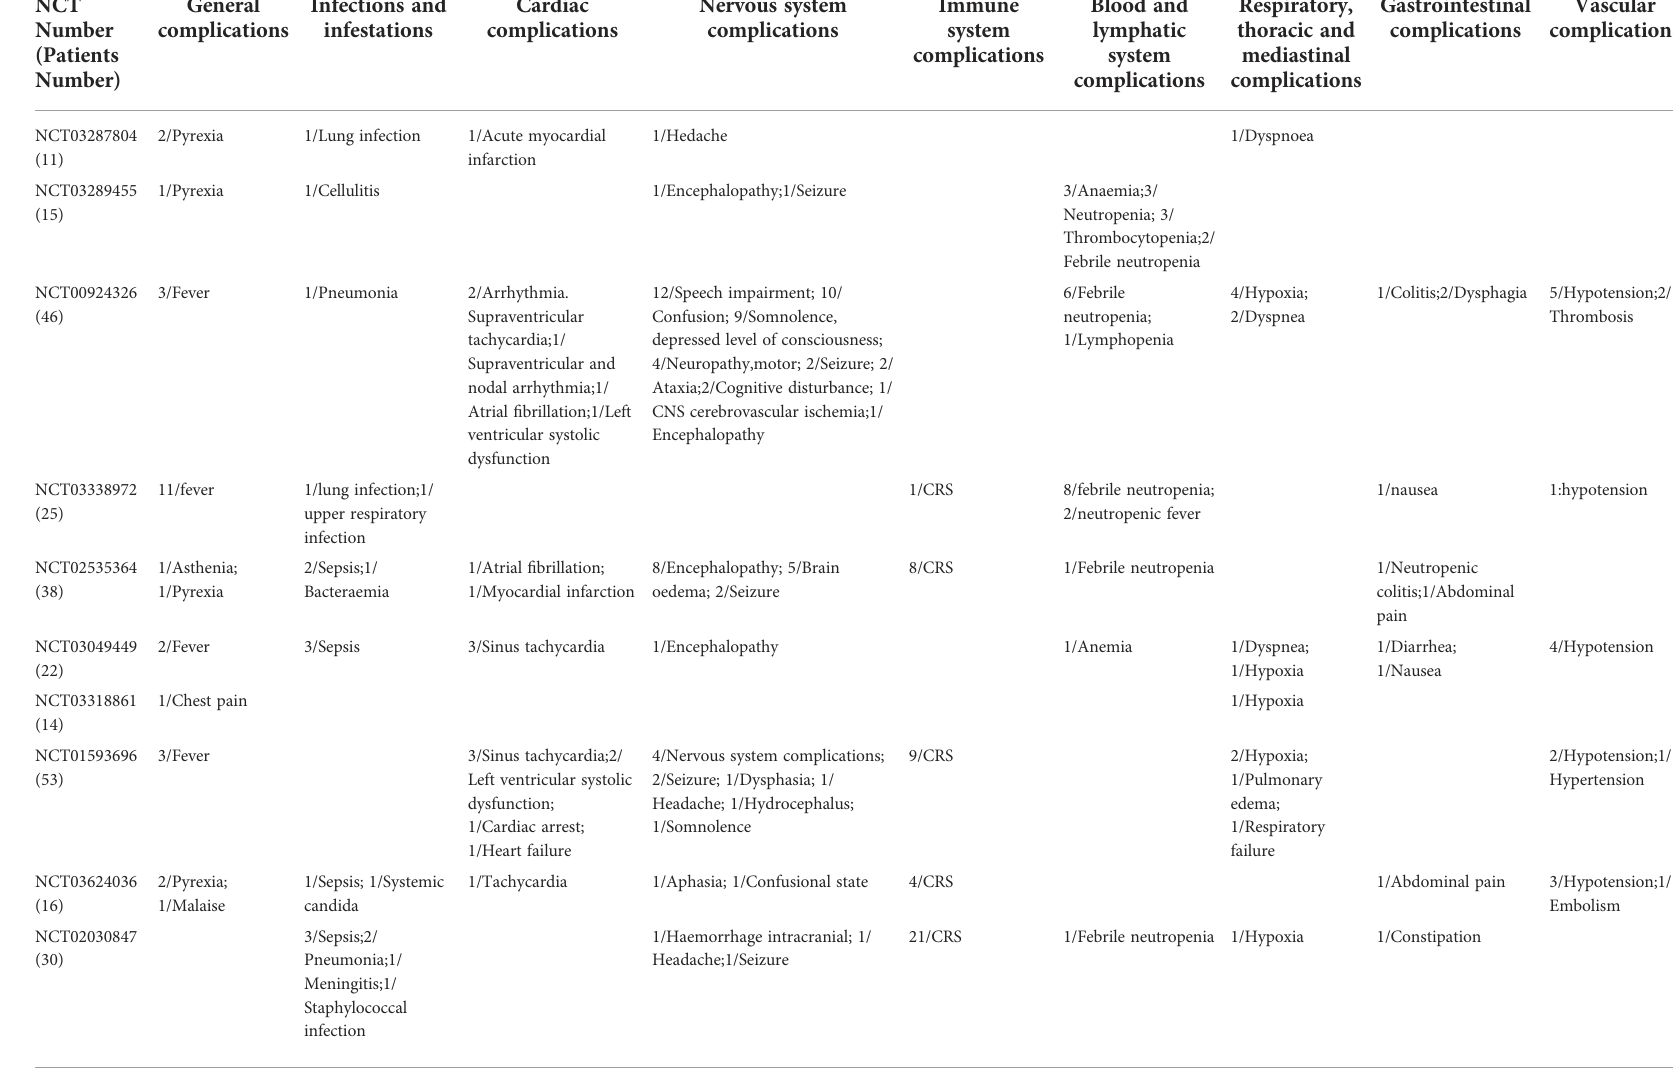
TABLE 2 Summary of clinical serious adverse events of CAR-T in hematological tumors(Patients